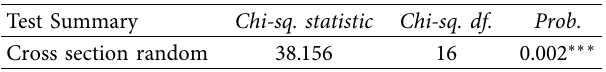
Table 9: The results of the Hausman